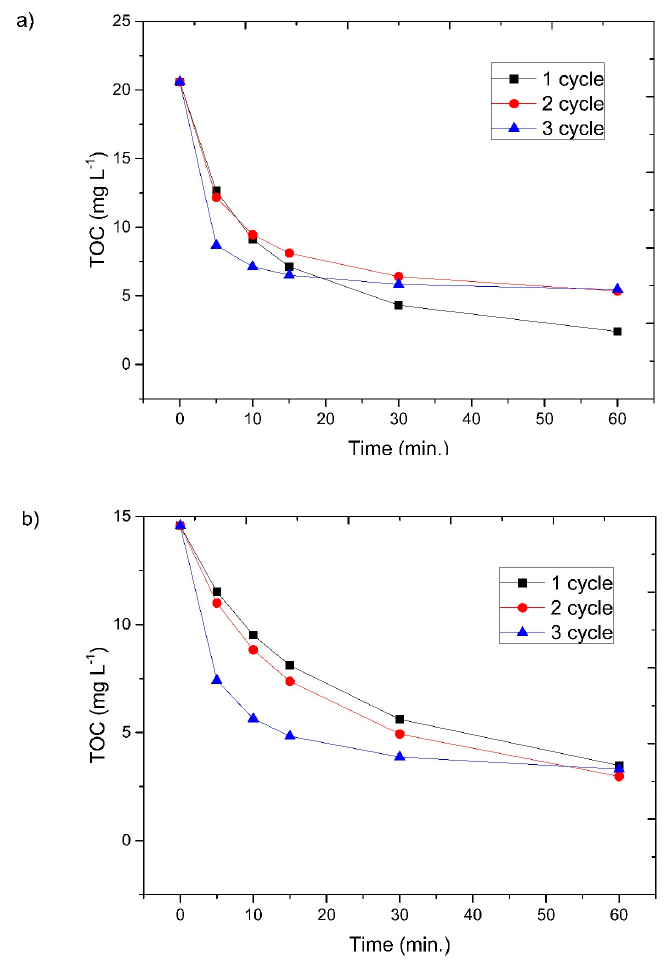
Figure 10. Reusability for three cycles with optimal parameters of 400 mg L − 1 H 2 O 2 , pH 3, and UV irradiation: ( a ) with 500 mg ZVI and 50 mg L − 1 AM E123 and ( b ) with 100 mg ZVI and 50 mg L − 1 AM ACID.